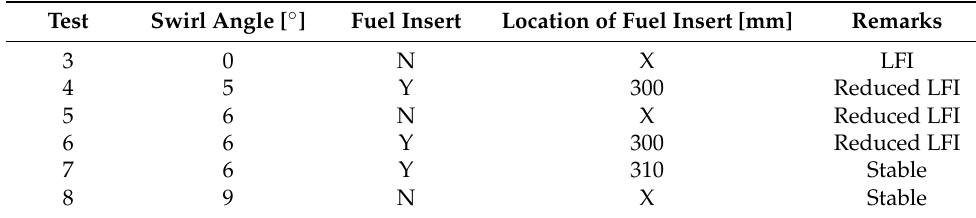
Table 2. Summary of test conditions.